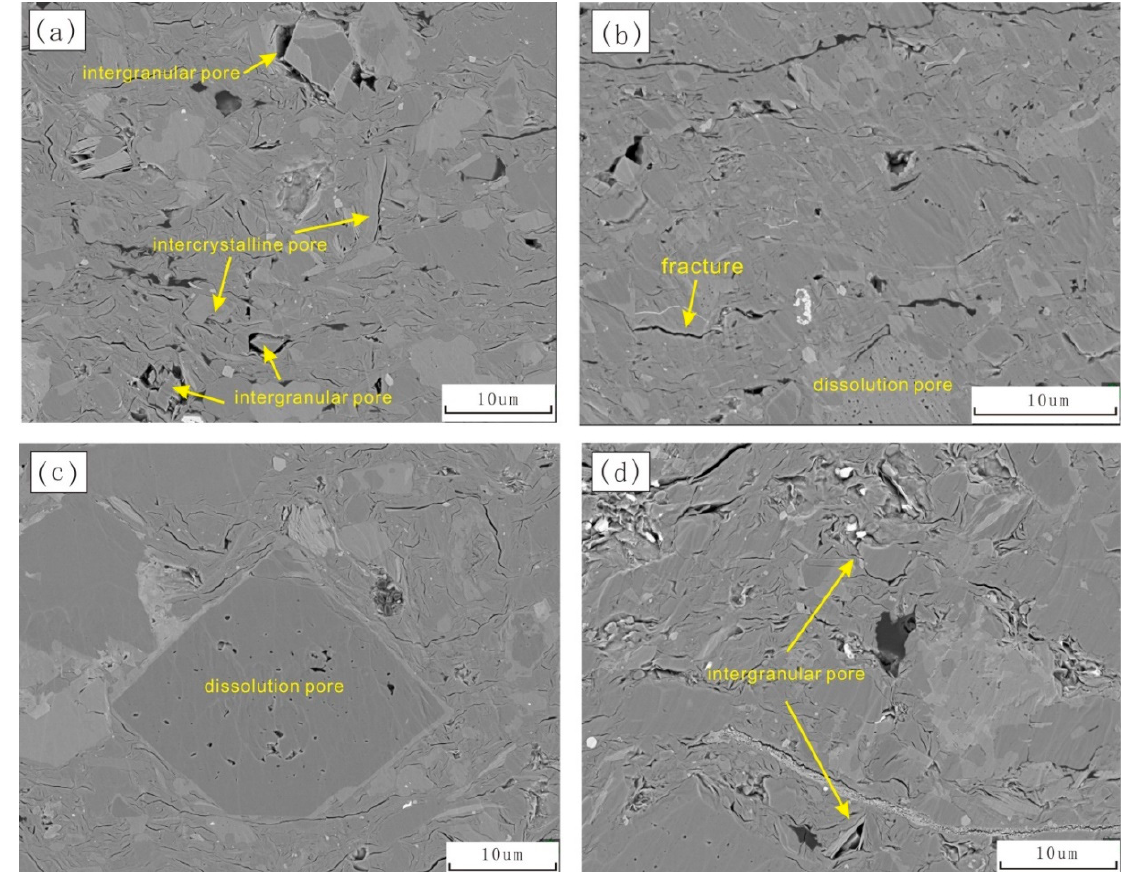
Figure 9. SEM pore characteristics of different shale lithofacies of Es3 in F39x1. ( a ) Thin laminar shale, 4385.4 m; ( b ) medium organic matter thick laminar shale, 3893.5 m; ( c ) low organic matter thick laminar shale 3899.77 m; ( d ) low organic matter massive mudstone, 3986.8 m.